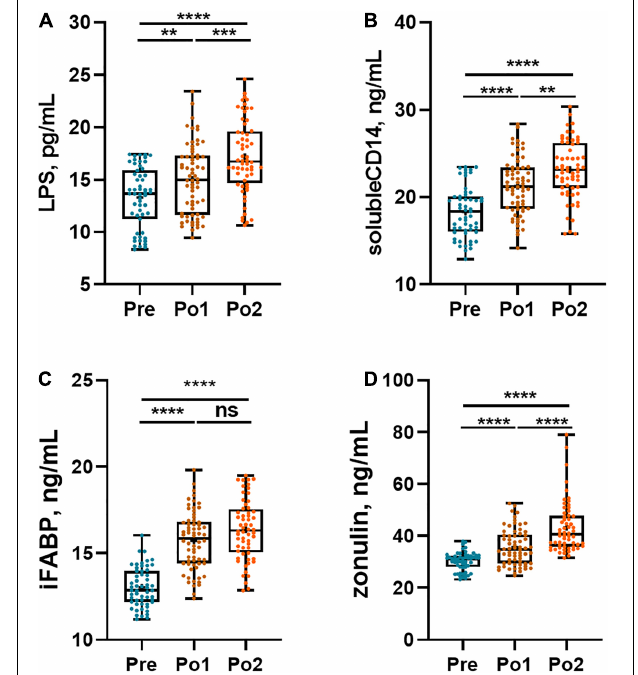
FIGURE 2 | Perioperative intestinal local inflammation and immunity biomarkers of cohorts. Fecal lipocalin-2 (A) , calprotectin (B) , sIgA (C) , and β -defensins-2 (D) were assessed across time series. Statistical assessment was carried out with one-way analysis of variance or Kruskal–Wallis test for parametric or non-parametric data followed by post hoc test using Dunn’s multiple comparison test. P < 0.05 indicates statistical significance (* P < 0.05, ** P < 0.01, *** P < 0.001, and **** P < 0.0001), and ns means P > 0.05. Results are expressed as median and quartile.